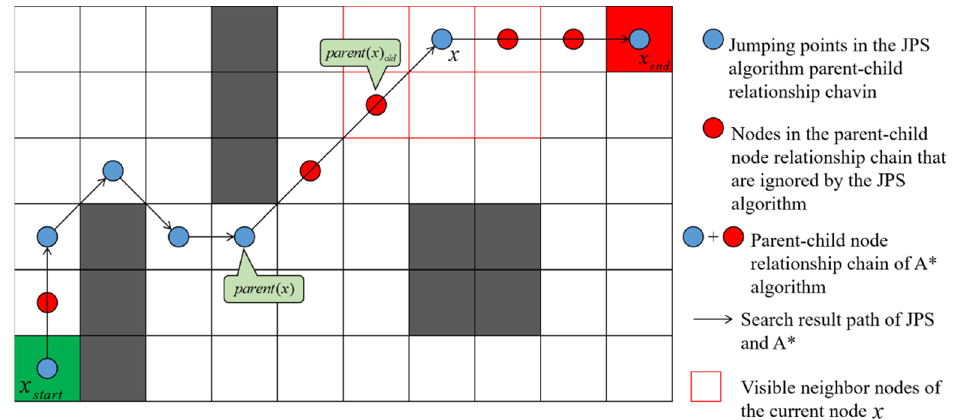
Figure 10. JPS algorithm parent–child node relationship chain.